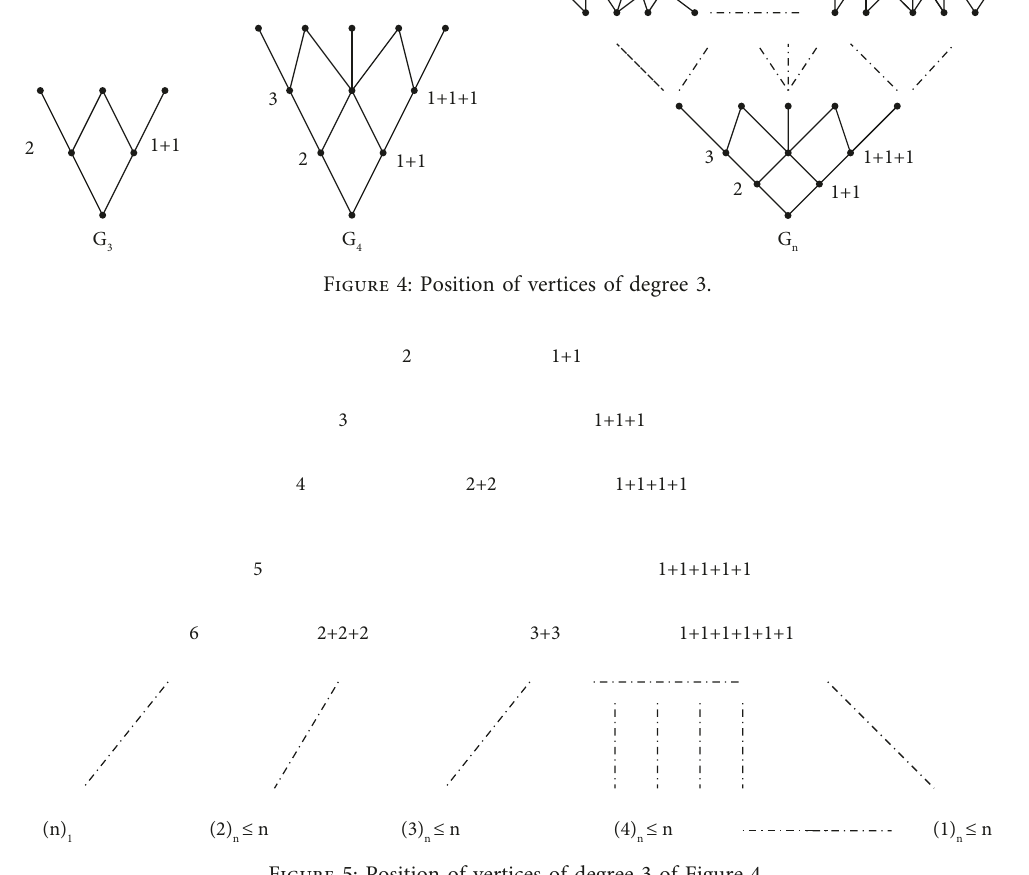
Figure 5: Position of vertices of degree 3 of Figure